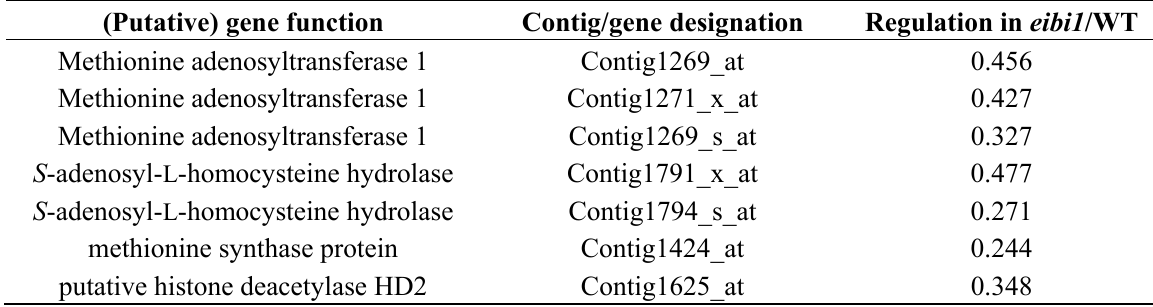
Table 3. Differentially expressed epigenetic modifying